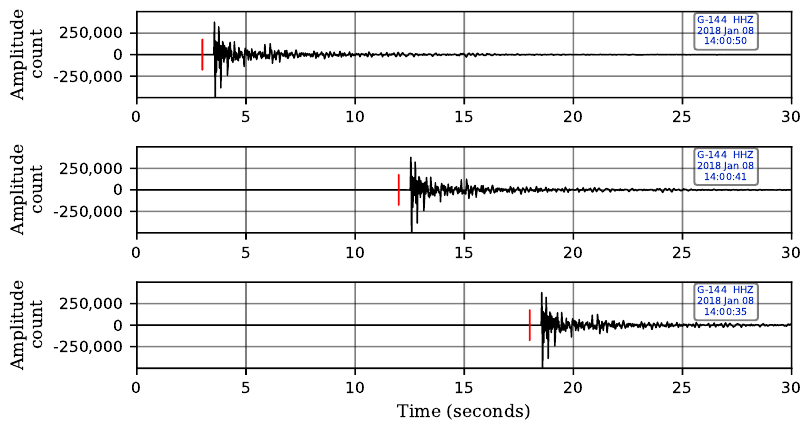
Figure 4. Three examples of the shifts done on an event time-window. Each event window is taken 17 times with 17 different placements of the arrival time to the window start: 3 s shift ( top ), 12 s ( middle ), 18 s ( bottom ). Red lines indicate the first-arrival times. The output after the afore-mentioned pre-processing workflow is a 30 s time-window labeled into either signal or noise. The shape of each training data is a 3D matrix whose dimensions are: 4 (number of velocity geophones) × 3001 (time-window length × sampling rate) × 3 (the 3-components of each sensor). This is an analogous set up to the one used in the classification of color images, where the first two dimensions are the image length and width, and the third dimension represents the three color channels (red, green, and